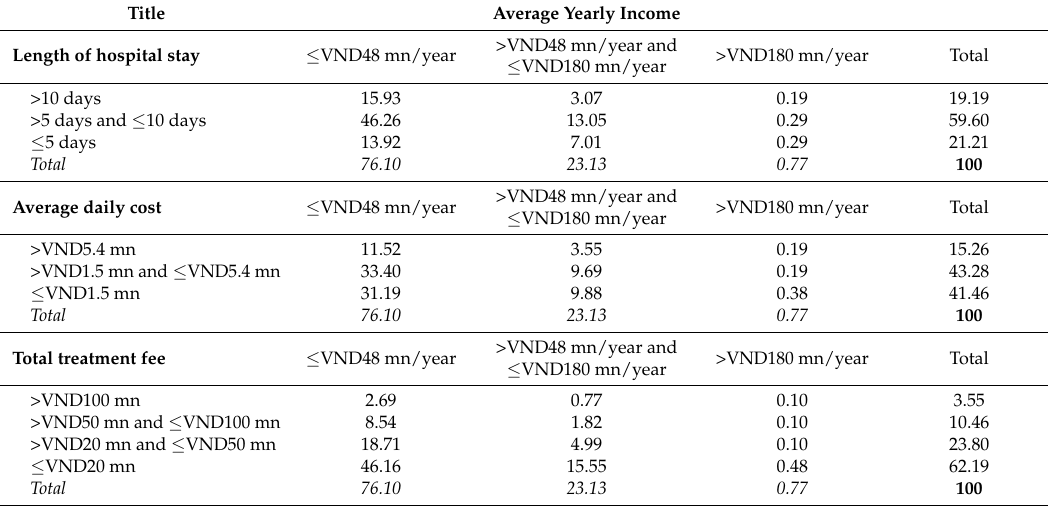
Table 1. Distributions of patients towards their length of hospital stay, average daily cost and total treatment fee and average yearly income, unit: %.